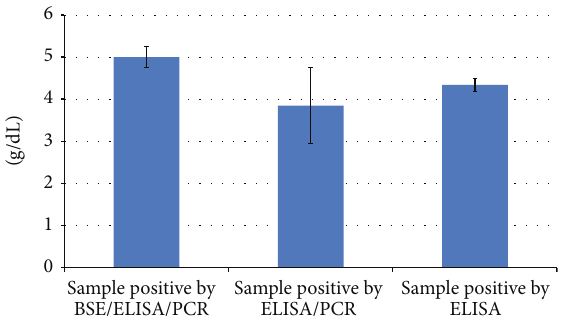
Figure 4: Serum globulin level in three groups tested positive by Blood Smear Examination (BSE), Enzyme Linked Immunosorbent Assay (ELISA), and Polymerase Chain Reaction